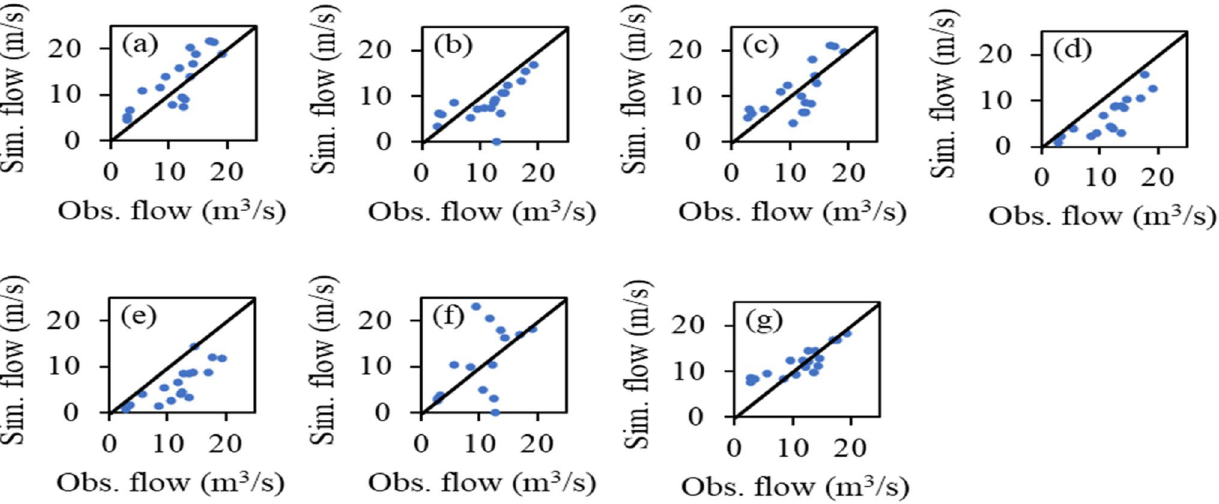
Fig. 7 Model performance assessment based on comparison of observed and simulated annual minima flows in each year for a AWBM, b SAC, c TANK, d IHACRES, e SIMHYD, f SMAR, g HMSV; Sim. stands for simulated, while Obs. means